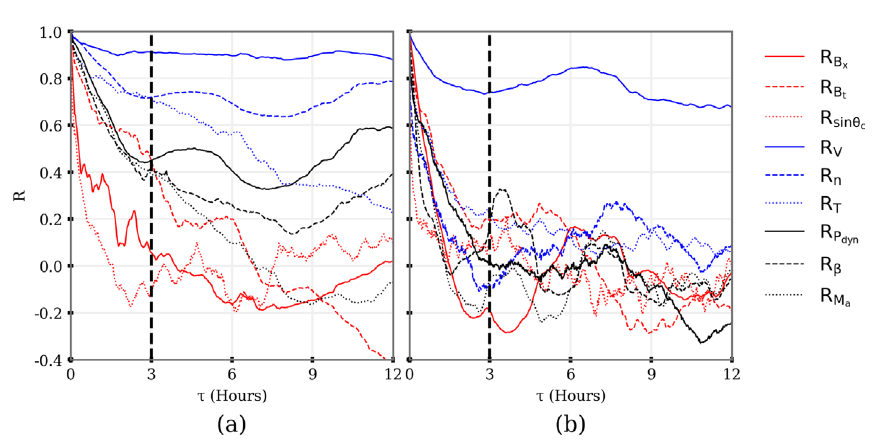
Fig. 1. Auto-correlation functions of different solar-wind parameters during: (a) solar minima, and (b) solar